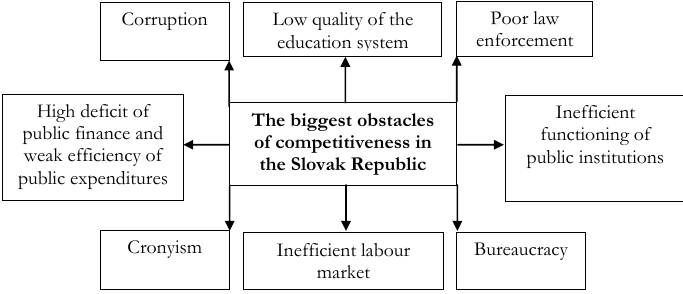
Fig. 3 – The biggest obstacles that decrease the level of competitiveness in the Slovak Republic. Source: own research The Slovak Republic was perceived as the state applingreforms, but from 2004, the entrepre- neurs did not obtain reforms that would significantly improve business conditions. The biggest obstacles that decrease the level of competitiveness in the Slovak Republic are in Figure